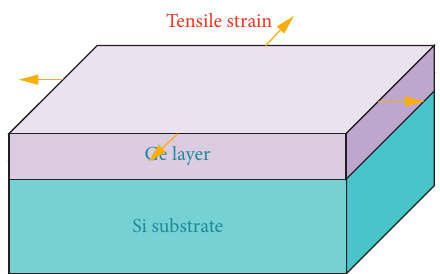
Figure 1: Schematic diagram of infinite energy transfer [1]. Figure